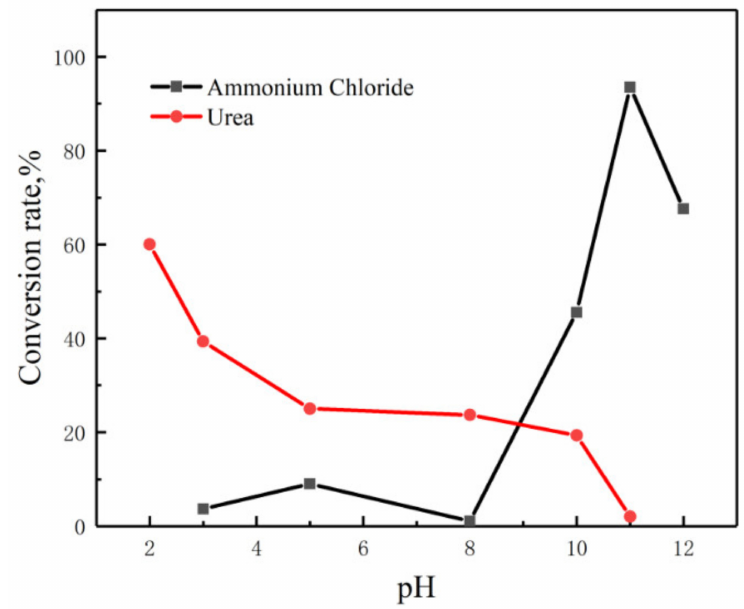
Figure 5. Effect of pH on the digestion of ammonium chloride and